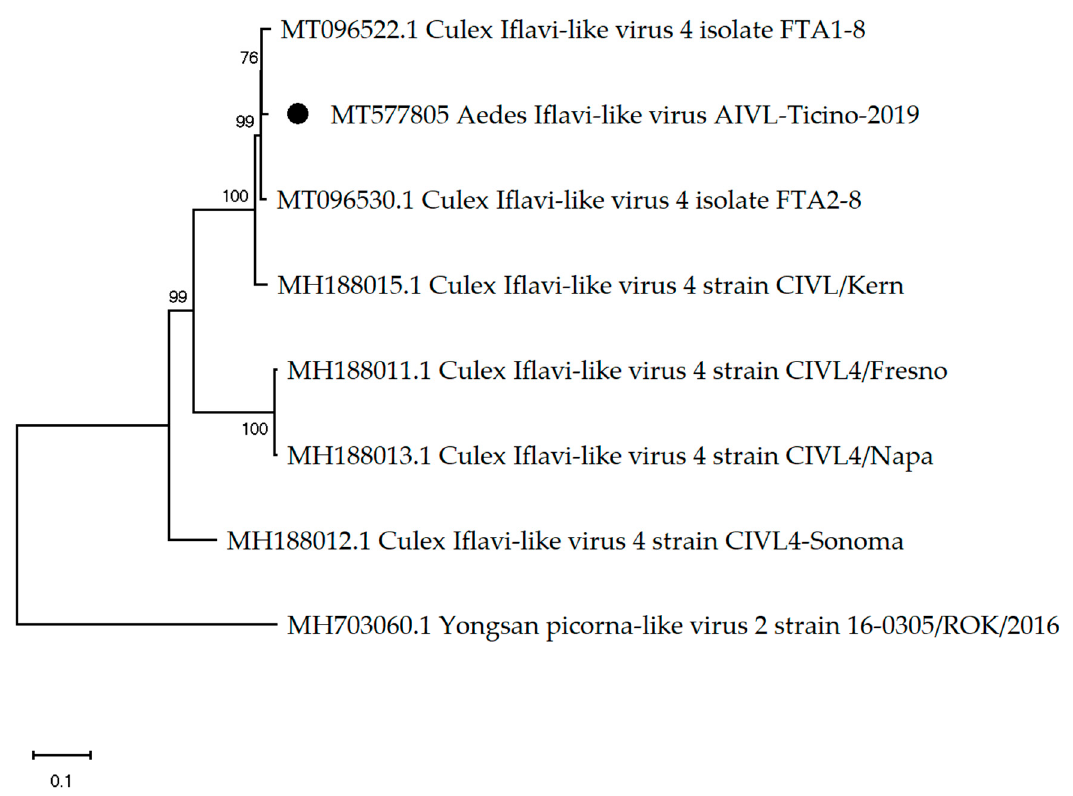
Figure 3. The phylogenetic tree of Aedes iflavi-like virus constructed using the maximum likelihood method and Kimura 2-parameter model. The percentage of replicate trees in which the associated taxa clustered together in the bootstrap test (1000 replicates) are shown next to the branches. The black dot indicates the genome sequenced in this study.